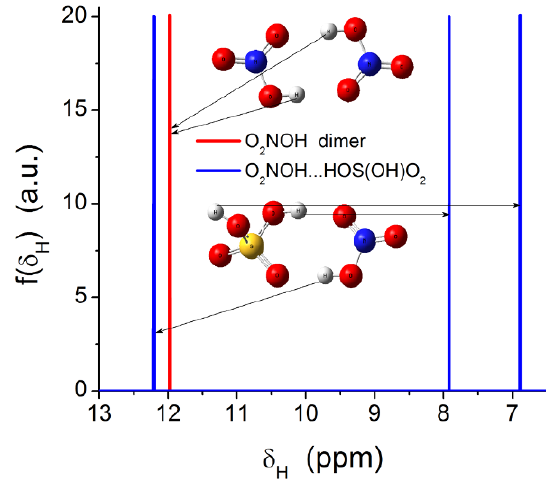
Figure 7. Calculated 1 H NMR spectra (GIAO/SMD/B3LYP/6- 31G(d,p), water as a solvent) of dimers nitric acid and dimer with nitric and sulfuric acids.